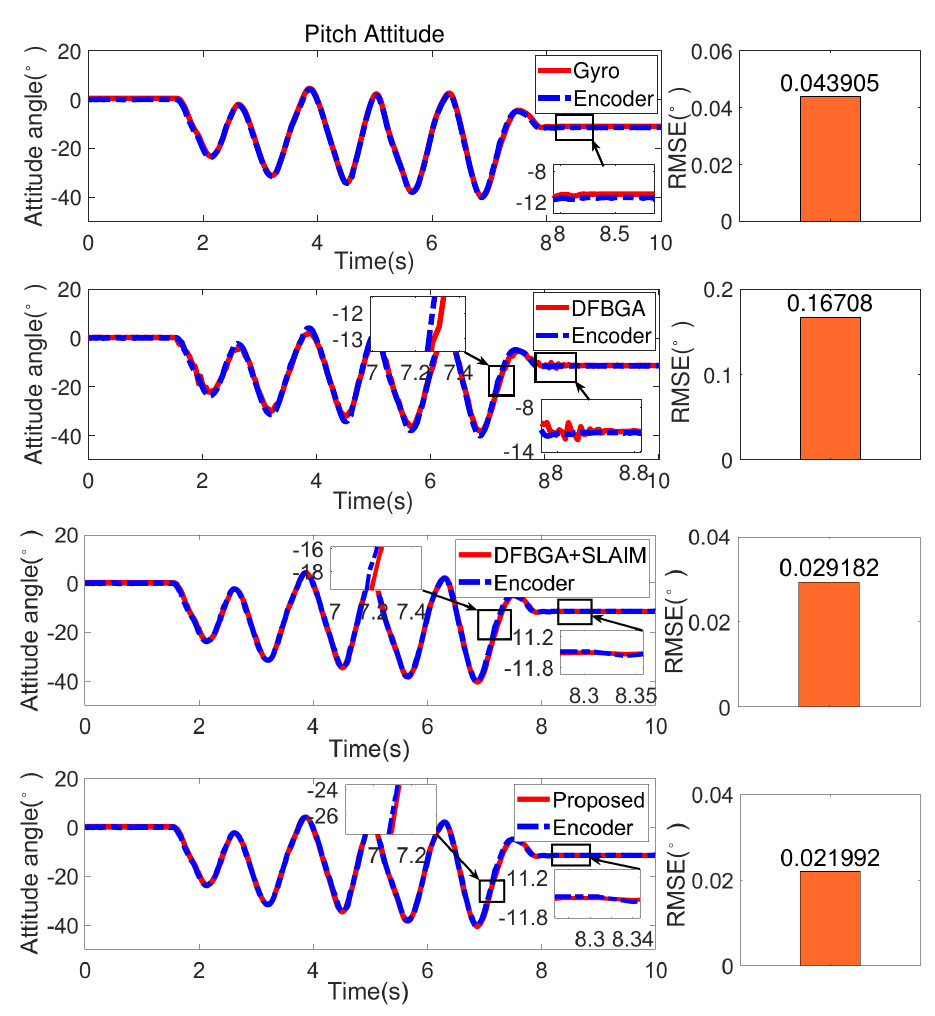
Figure 14. Pitch angular attitude comparison. The first subfigure is the attitude calculated by gyro, the second subfigure is the attitude processed by DFBGA, the third subfigure is the attitude processed by DFBGA and SLAIM, the fourth subfigure is the attitude processed by proposed method.